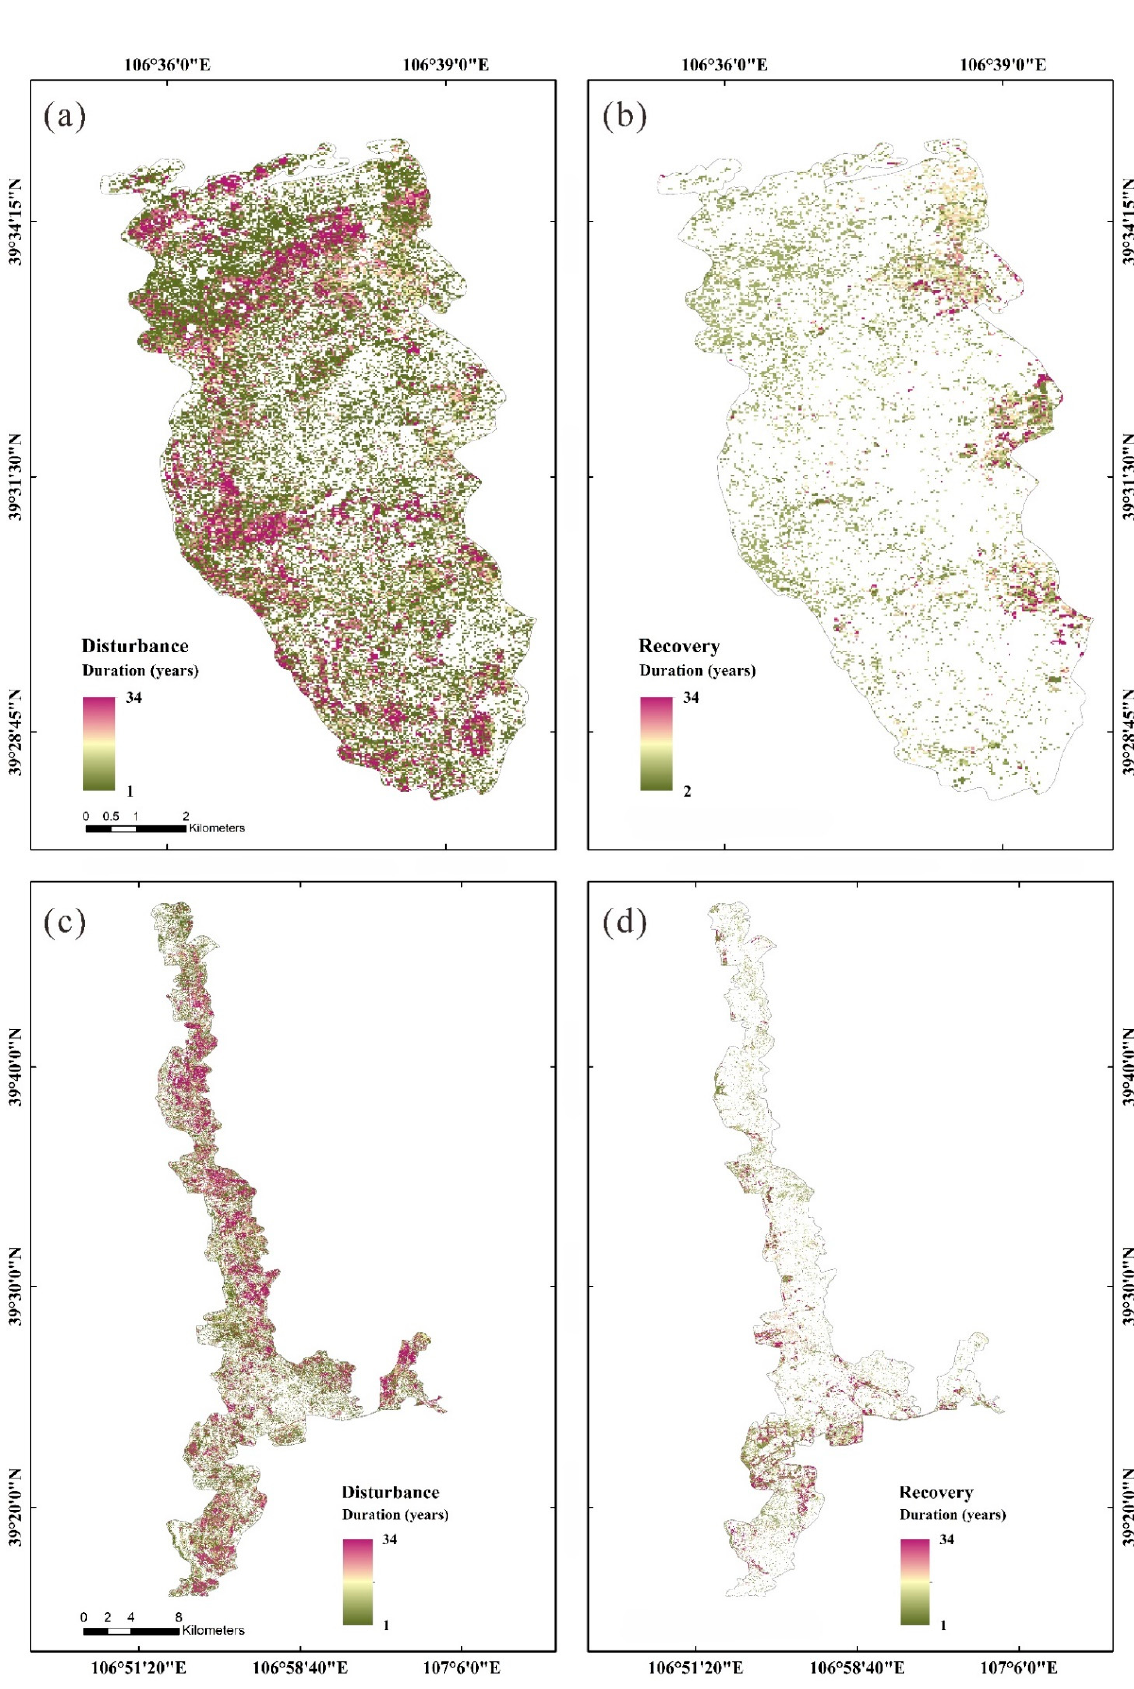
Figure 6. The duration of disturbance and recovery. ( a ) disturbance in the western mine; ( b ) recovery in the western mine; ( c ) disturbance in the eastern mine; ( d ) recovery in the eastern